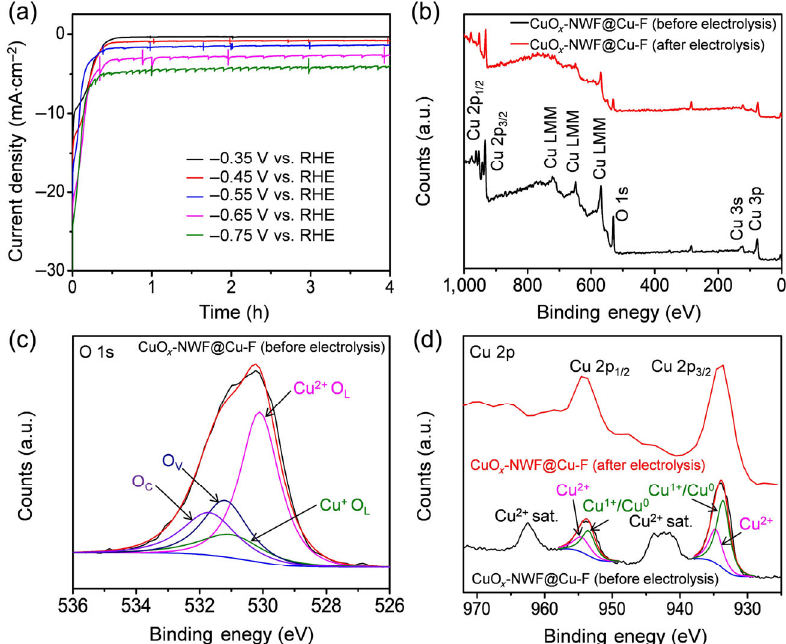
Figure 2 The structural and compositional characterizations of CuO x -NWF@Cu-F. (a) Current density vs. time plots of CuO x -NWF@Cu-F electrode at different applied potentials from –0.35 to –0.75 V (vs. RHE) during CO 2 electroreduction. (b) XPS spectra of CuO x -NWF@Cu-F electrode before and after 20-min electrolysis of CO 2 reduction. (c) O 1s XPS spectrum of CuO x -NWF@Cu-F before electrolysis. (d) Cu 2p XPS spectra of CuO x -NWF@Cu-F before and after 20-min electrolysis of CO 2 reduction,